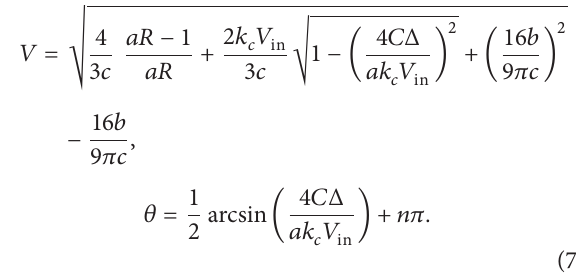
= 40𝜇 A / V 2 , 𝑐 + 𝑐 = 115 𝜇 A / V 3 , 𝑘 = −0.6 mA / V 2 , 𝑅 = 1950 Ω , and 𝑉 in nl in = −0.083 and 𝜆 𝑎 = 𝜆 = −0.202 𝑎 𝑏